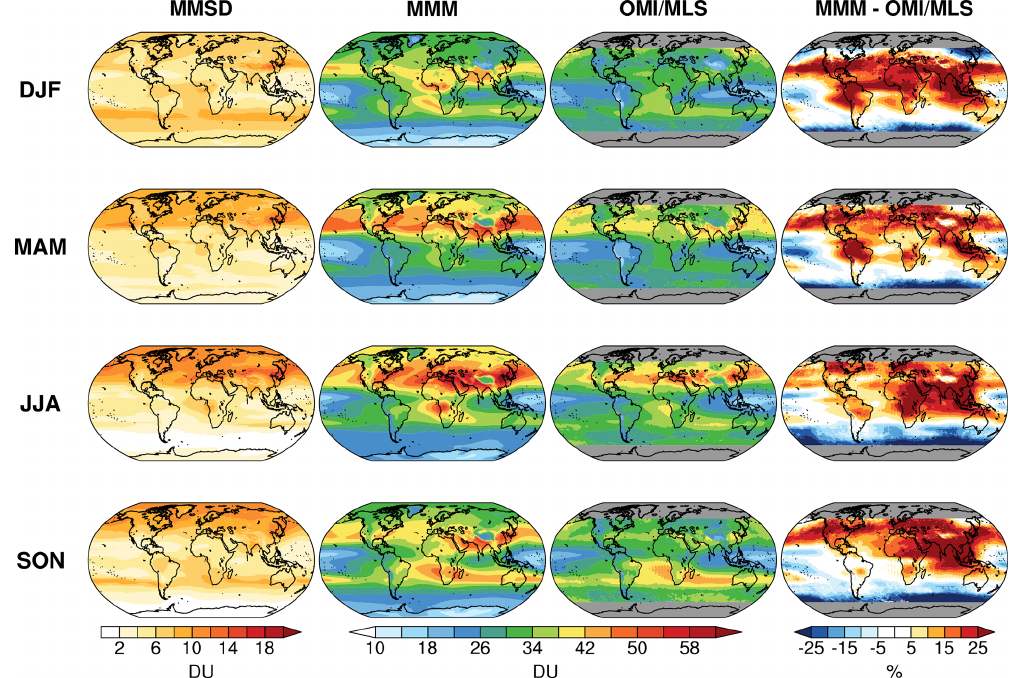
Figure 5. Comparison of the seasonal cycle of tropospheric column of ozone (TCO) abundances with satellite climatology for the period 2005 to 2014. Each row shows a separate meteorological season, from top to bottom: December to February (DJF), March to May (MAM), June to August (JJA) and September to November (SON). The left column shows the inter-model standard deviation of seasonal mean TCO in the CMIP6 ensemble in Dobson units (DU). The second column from the left shows the multi-model seasonal mean TCO in DU. The second column from the right shows the seasonal mean TCO in the OMI/MLS product (Ziemke et al., 2006). The right column shows the relative bias in the multi-model seasonal mean relative to the OMI/MLS product in percent